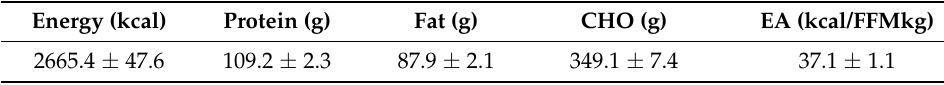
Table 2. Mean values of energy and macronutrient